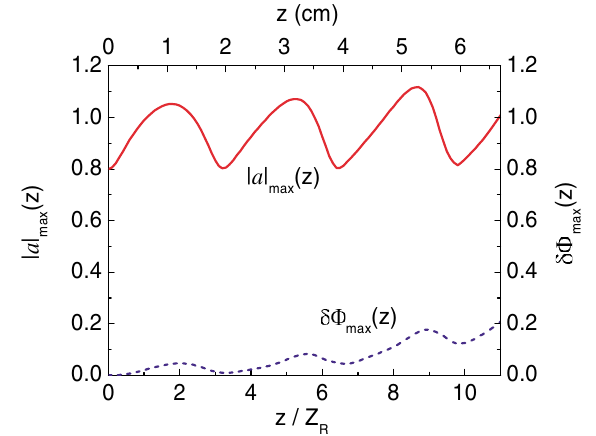
FIG. 1. (Color) The maxima of the laser pulse field on axis j a (cid:8) r (cid:5) 0 ; z (cid:9)j (solid line) and the maximum of the wakefield max (cid:8) r (cid:5) 0 ; z (cid:9) (cid:5) (cid:25) (cid:8) r (cid:5) 0 ; z (cid:9) (cid:2) 1 behind the potential , (cid:25) max max pulse (dashed line) versus propagation distance z (normalized (cid:5) k r 2 and in cm). The laser spot to the Rayleigh length Z R 0 L (cid:5) 101 (cid:2) m , laser field a (cid:5) 0 : 8 , and channel radius radius r L 0 (cid:5) 202 (cid:2) m (see Table I for other parameter values). R ch The plasma channel is assumed to be parabolic, (cid:5) r 2 (cid:8) r (cid:9) (cid:5) n (cid:8) r (cid:5) 0 (cid:9) n 1 (cid:6) 0 0 R 2